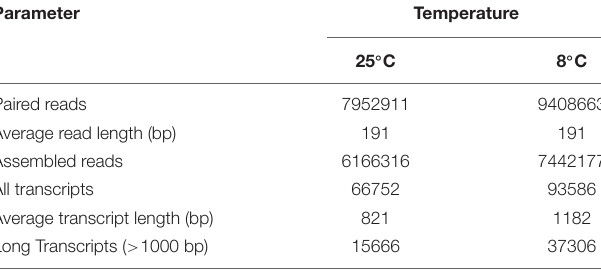
TABLE 1 | Summary statistics for goldfish